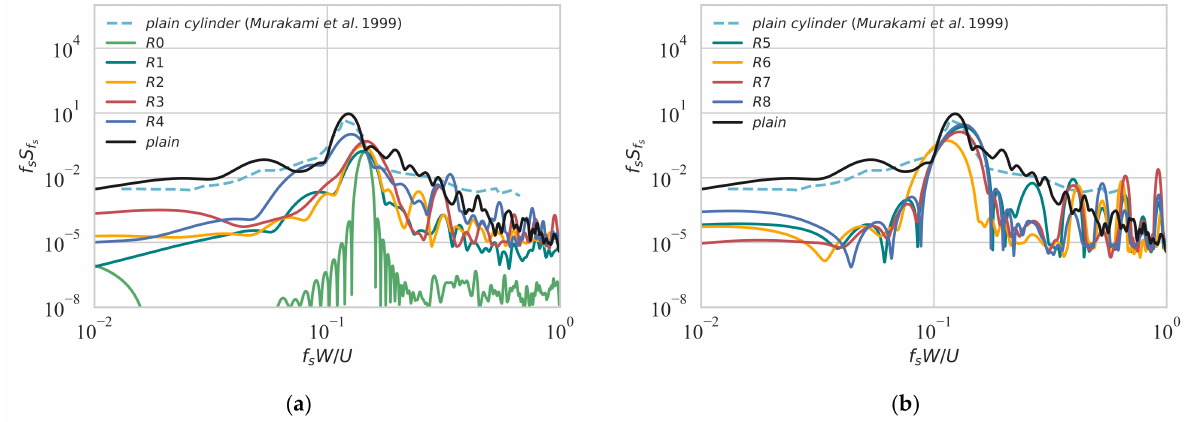
Figure 11. Power spectra of lift forces for the nine rotating cases and plain cylinder: ( a ) V t / f s < 1; ( b ) V t / f s ≥